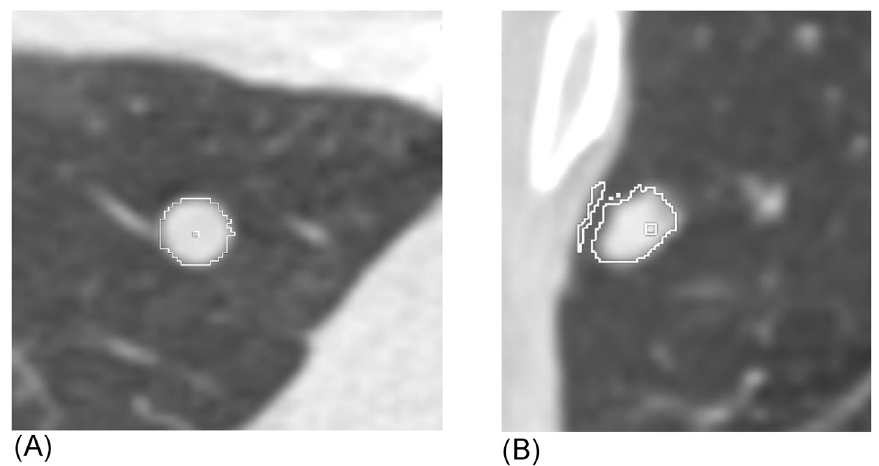
Fig 1. Example of automated volume extraction of a calcified nodule by VCAR software. (A) Successful extraction: Note the contour fit to the nodule perimeter in multiple projections appears to correlate with the visual nodule outline. (B) Unsuccessful extraction: Note the clear erroneous border that includes adjacent chest wall in this subpleural nodule.